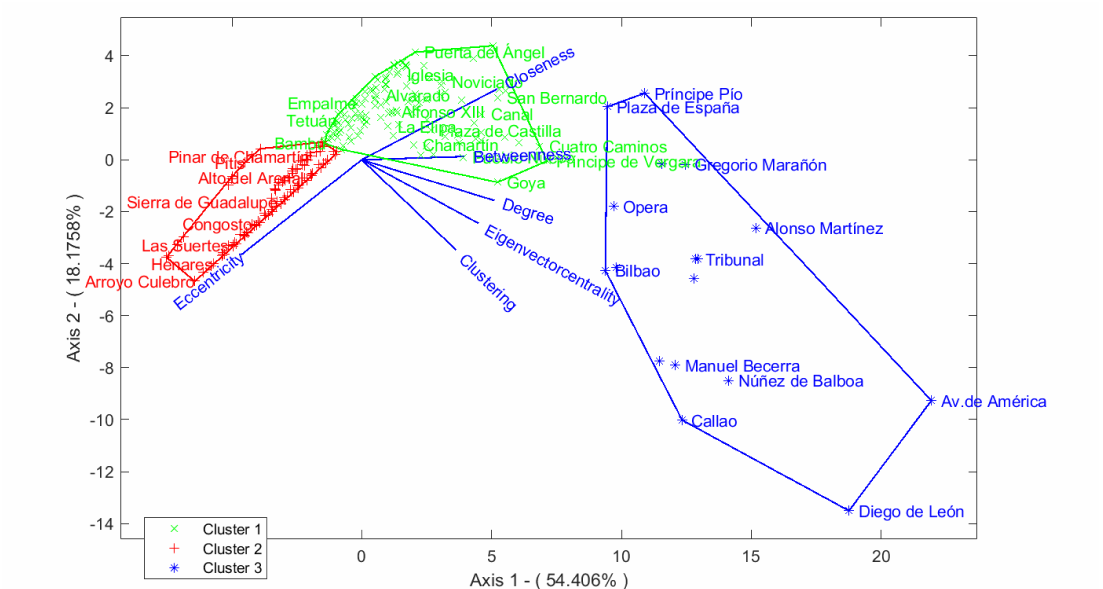
Figure 7. Factorial representation of the HJ-Biplot for clusters, plane